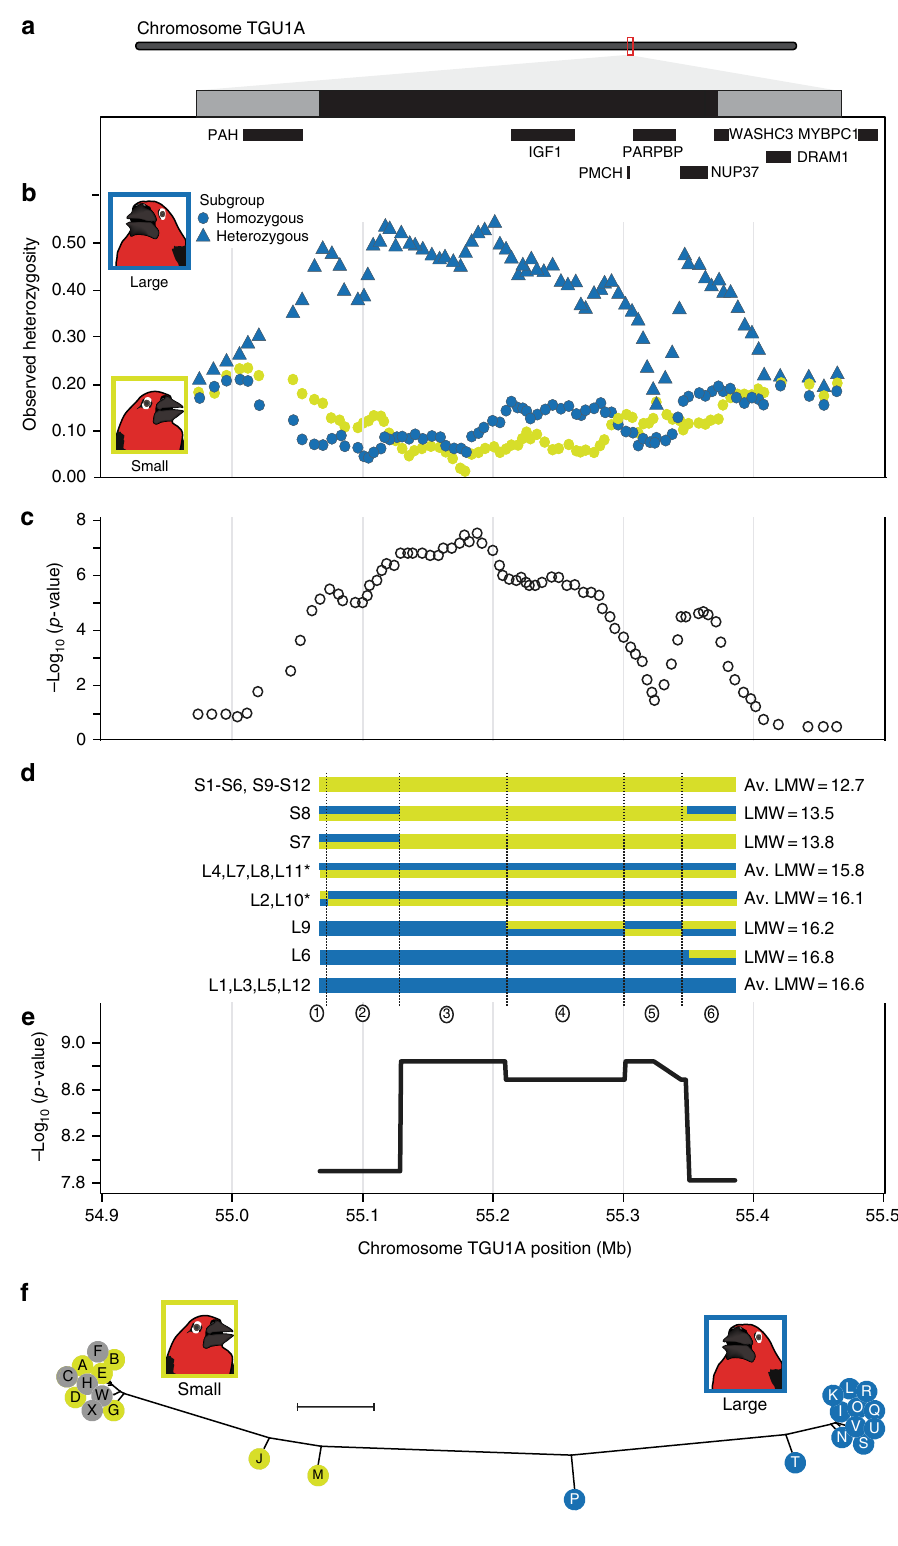
mm); large-billed individuals with low heterozygosity, hereafter referred to as the homozygous subgroup ( n = 6, mean H O = 0.132, mean LMW = 16.6 mm); and large-billed individuals with high heterozygosity, hereafter referred to as the heterozygous subgroup ( n = 6, mean H O = 0.366, mean LMW = 15.9 mm). The large-billed homozygous subgroup has marginally,